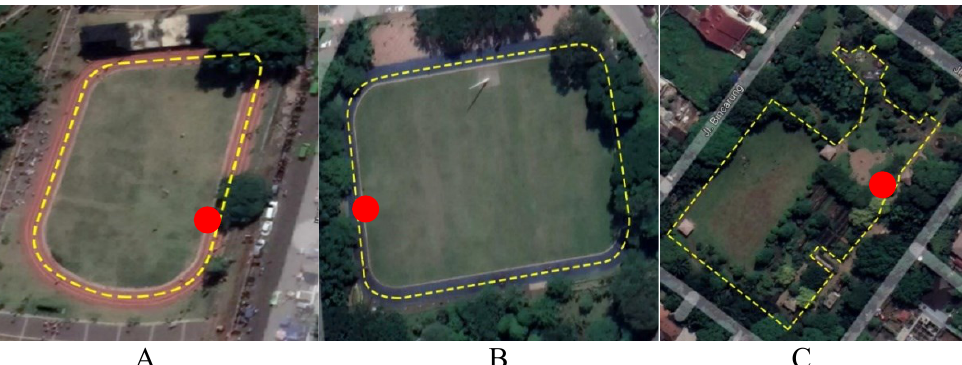
Figure 1. Experiment location. (A) Bogor City Alun-Alun. (B) Sempur Park. (C) Heulang Park Note: The yellow line is the walking track, and the red circle is the relaxed sitting